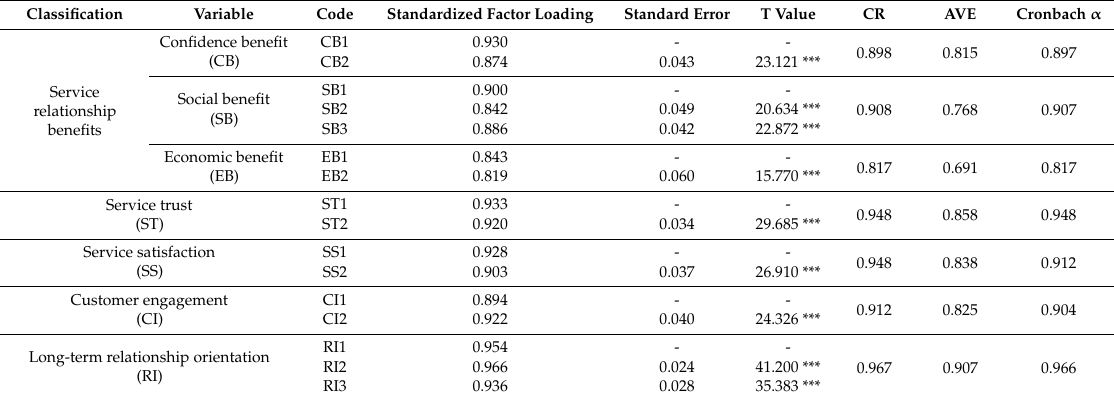
Table 3. Analysis of trust and convergent validity of the measurement model.